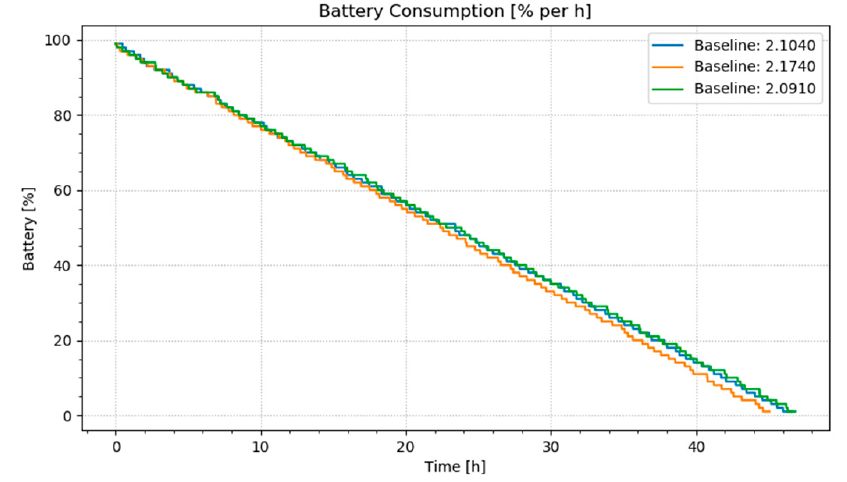
Figure 7. Baseline energy consumption on smartwatch over three runs from full charge until battery depletion.